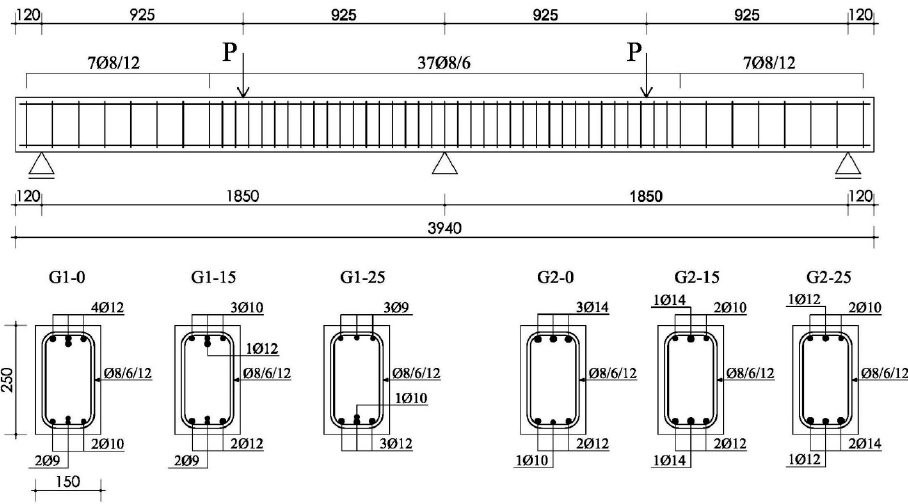
Figure 1. Geometry and section details for continuous tested beams (all dimensions in mm). Table 1. Reinforcement details and concrete compressive strength for tested beams.